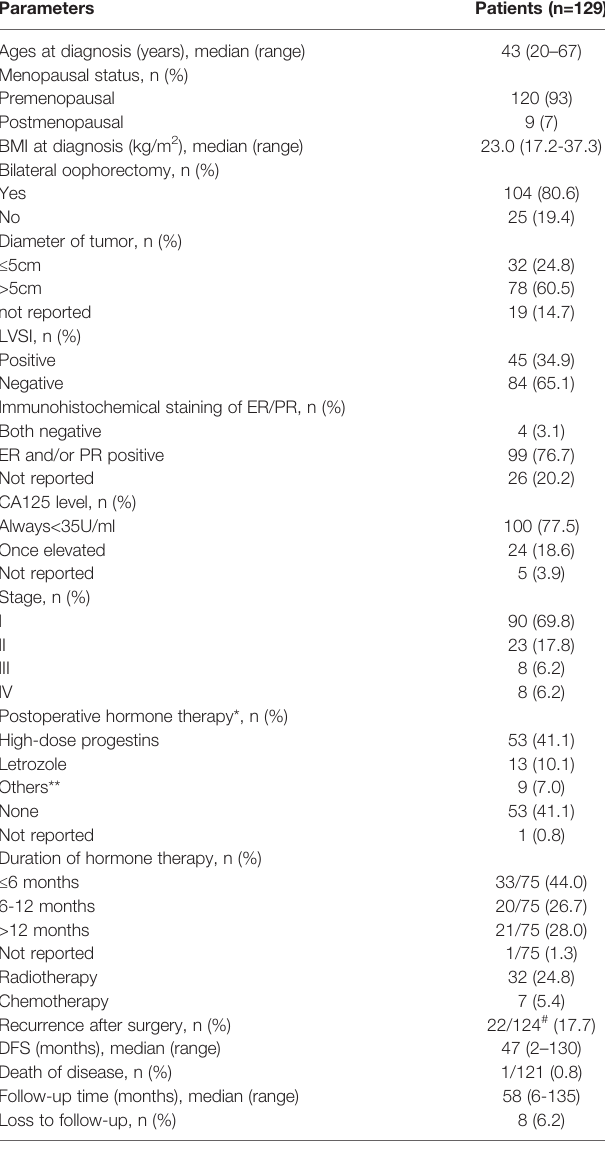
TABLE 1 | Epidemiological characteristics, treatment, and follow-up of the cohort without fertility-sparing.